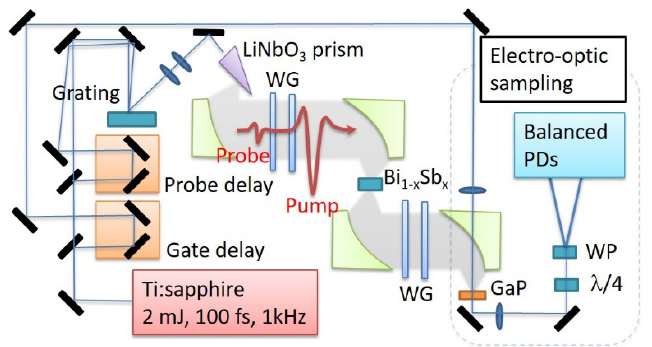
Fig. 1. Experimental setup for terahertz-pump and terahertz-probe spectroscopy. WG: wire-grid polarizer, WP: Wollaston prism, PD: